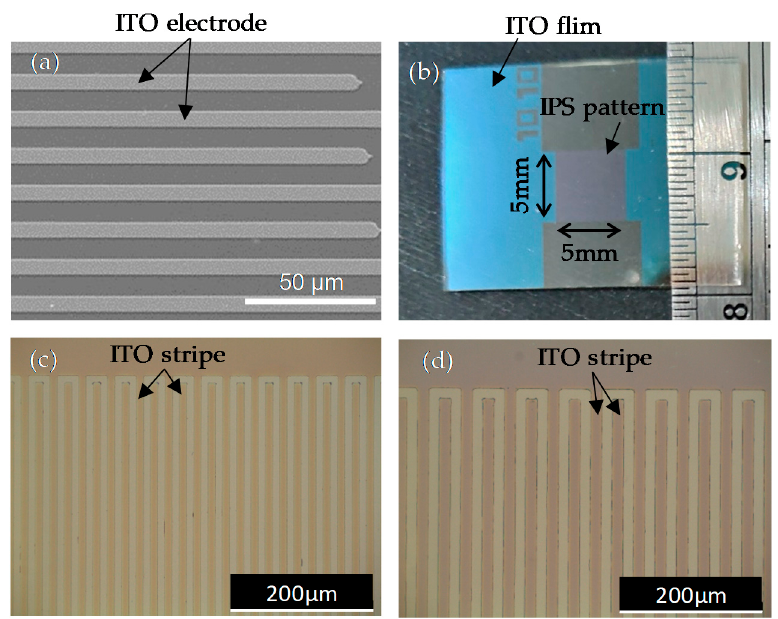
Figure 1. ( a ) The SEM image of the ITO conductive layer structure. ( b ) The image of ITO glass with an IPS pattern. Optical microscope images of designs of line width and space width of ( c ) 10 μ m and 10 μ m, and ( d ) of 15 μ m and 15 μ m.